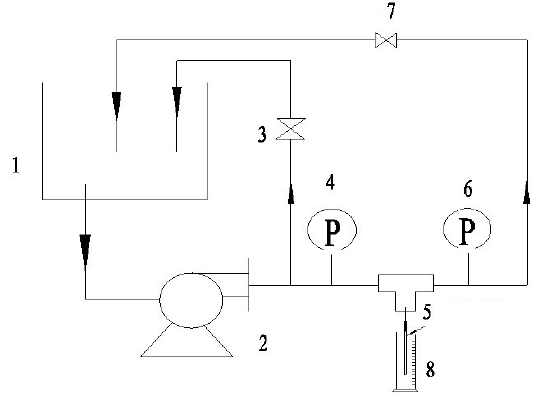
Figure 3. The schematic of the experimental systems used for the UF water flux and rejection of bovine serum albumin (BSA). 1: container; 2: magnetic drive pump; 3,7: valve; 4,6: precision gauge; 5: syringe needle; 8: measuring